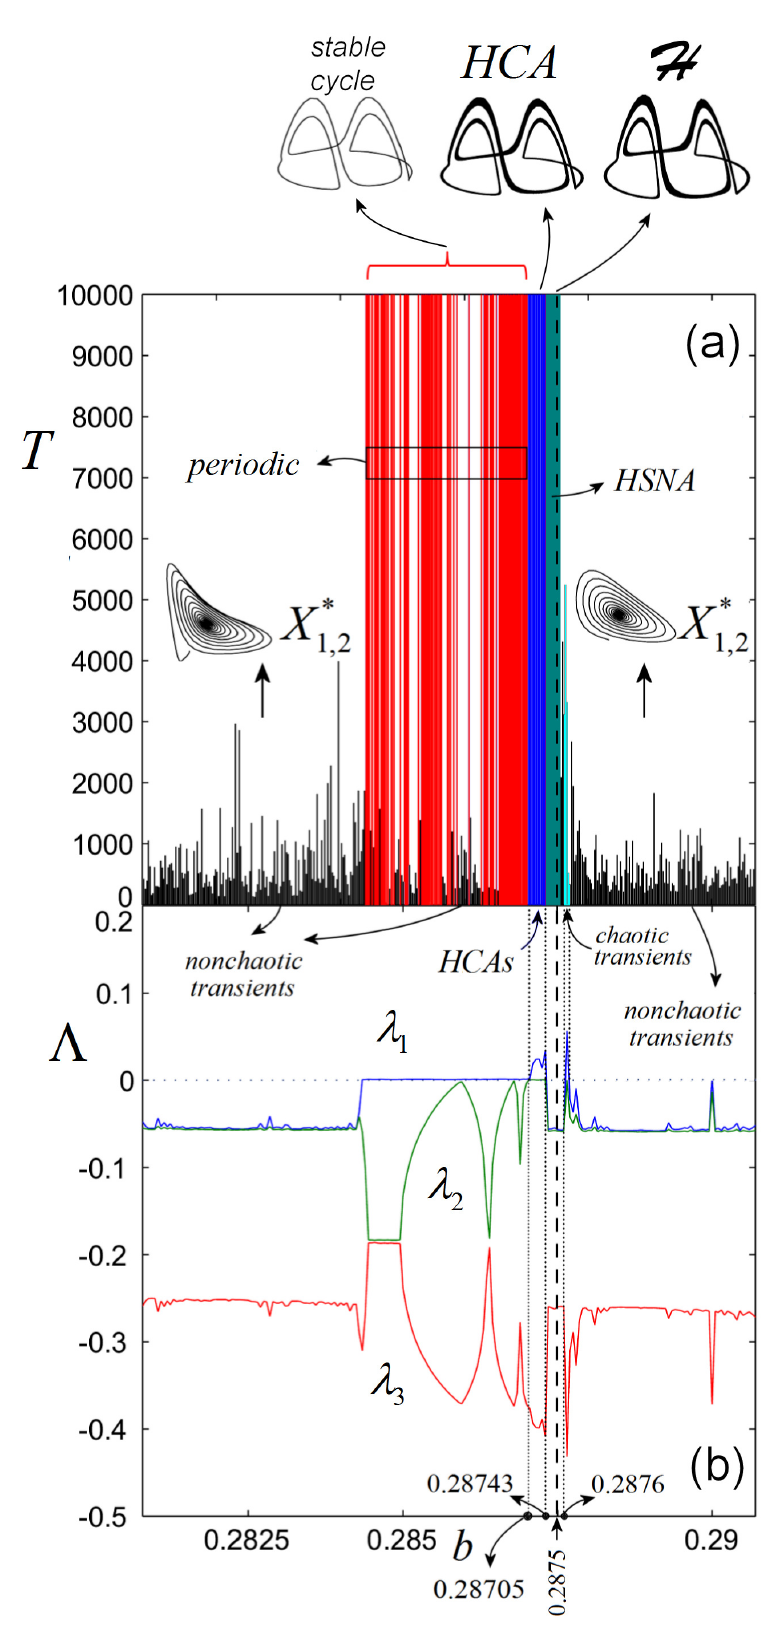
Figure 1. ( a ) Variation in lifetime intervals [ 0, T ] of the numerical trajectories; ( b ) The variation in Λ of the RF system for b ∈ [ 0.2808,0.2907 ]